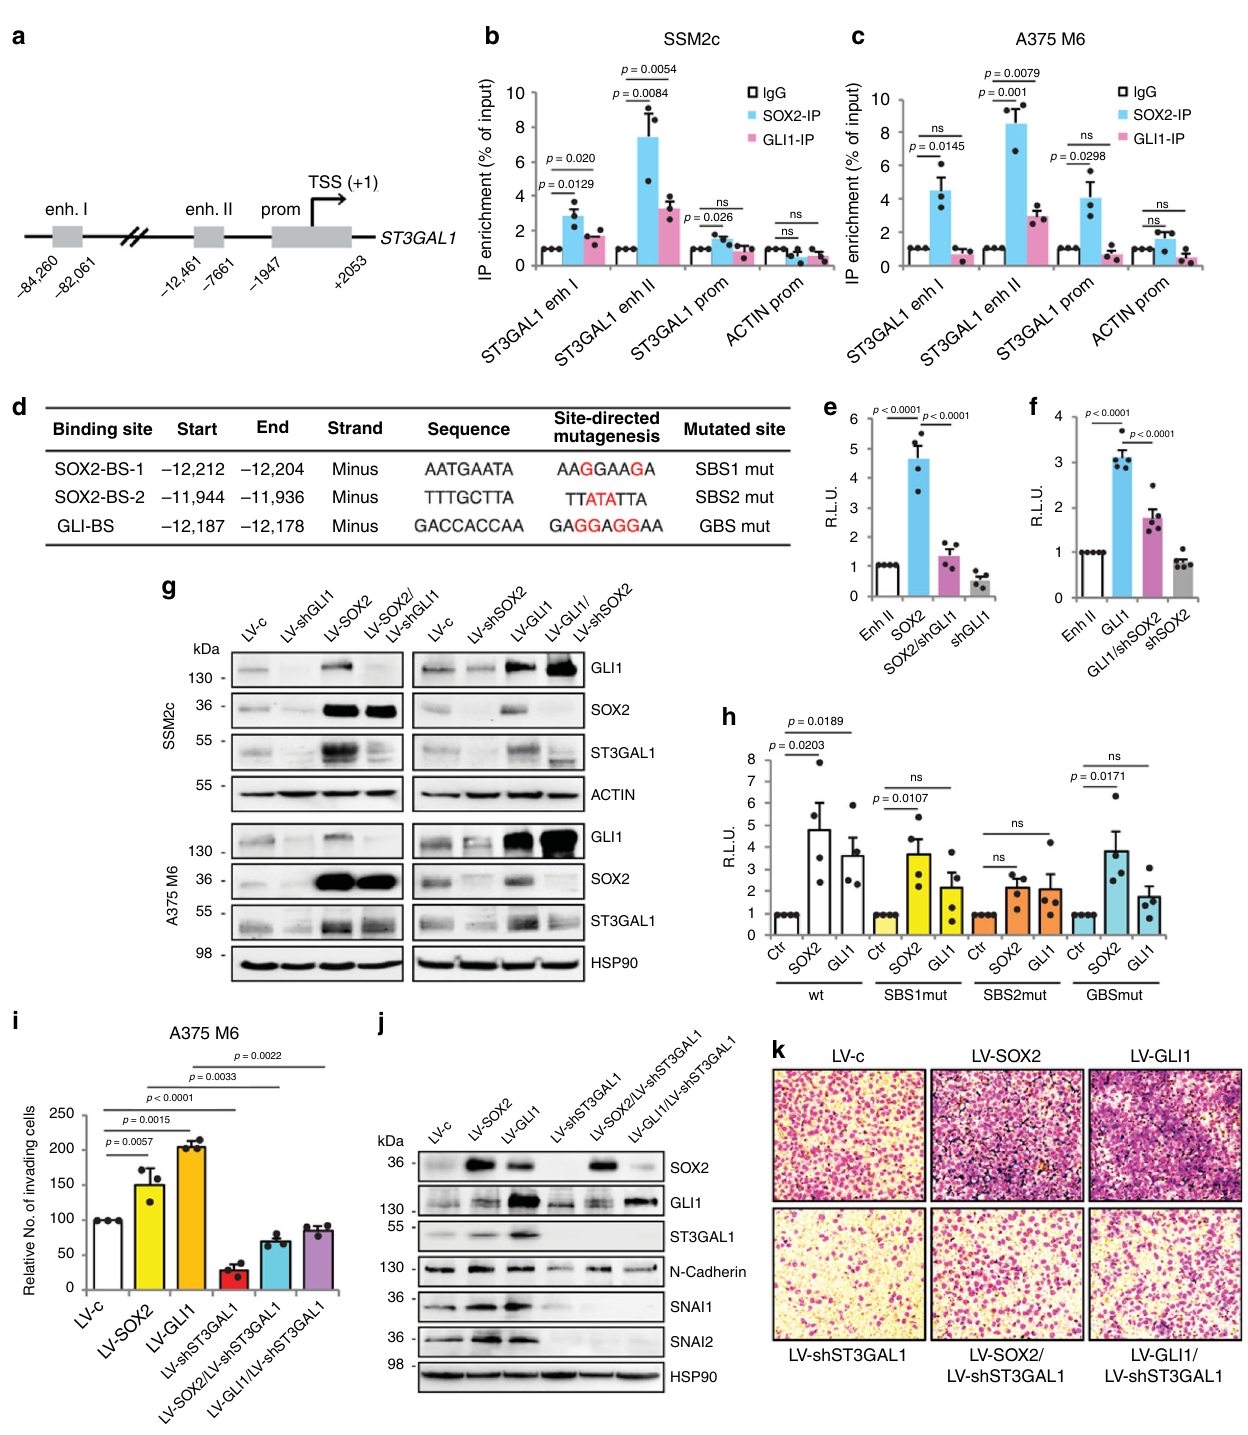
(late apoptosis) labeled cells was detected with a CytoFLEX S Flow Cytometer (Beckman Coulter) and analyzed using the CytExpert Software. For circulating melanoma cells analysis, 100 μ l of blood was collected from mice at surgery of the primary tumors by cardiac puncture through a syringe using heparin as anticoagulant 54 . Red blood cells (RBC) were removed by addition of RBC lysis solution (83 mg NH 4 Cl, 10mg KHCO 3 , 18 μ l EDTA 5%, ddH 2 O to a fi nal volume of 10ml) followed by centrifugation at 1200 × g for 10 min. Pellets were resuspended in 300 μ l in PBS before fl ow cytometry. GFP + -cells were detected with a CytoFLEX S Flow Cytometer. Sorting gates were drawn using A375 M6 GFP − and GFP + cells as the negative or the positive control, respectively. Blood sample from healthy mice was also used to exclude unspeci fi c fl uorescence signals